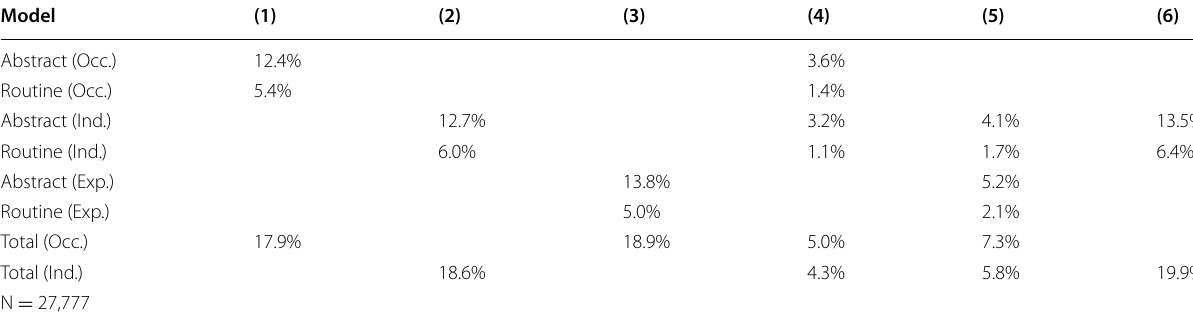
Table 8 Unique variation explained by task